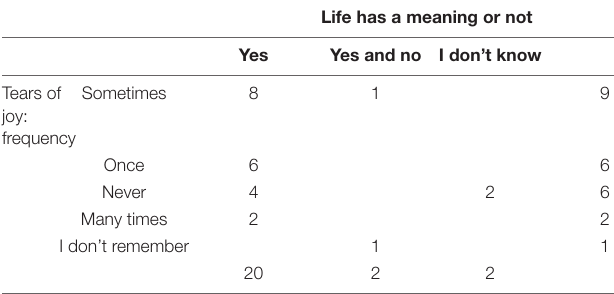
TABLE 6 | Shared segments between tears of joy and meaning of